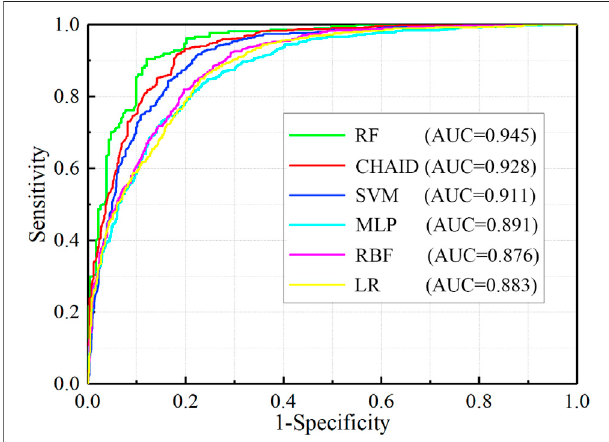
FIGURE 11 | AUC values of all machine learning models for CSP in Huichang